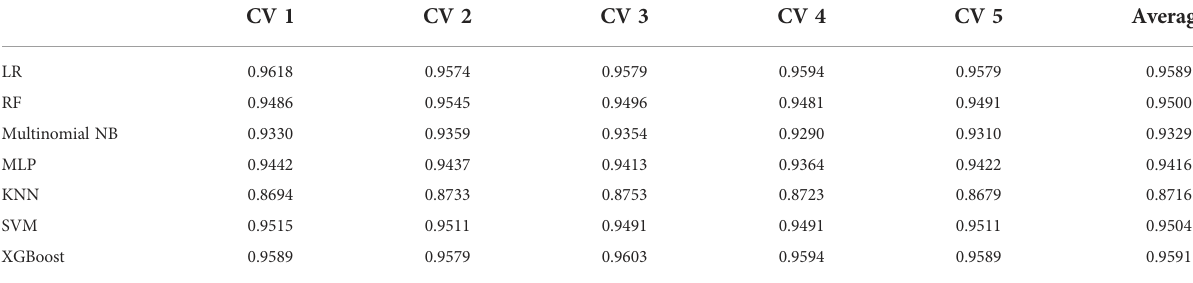
TABLE 2 The result of 5-fold cross-validation with 1 gram language